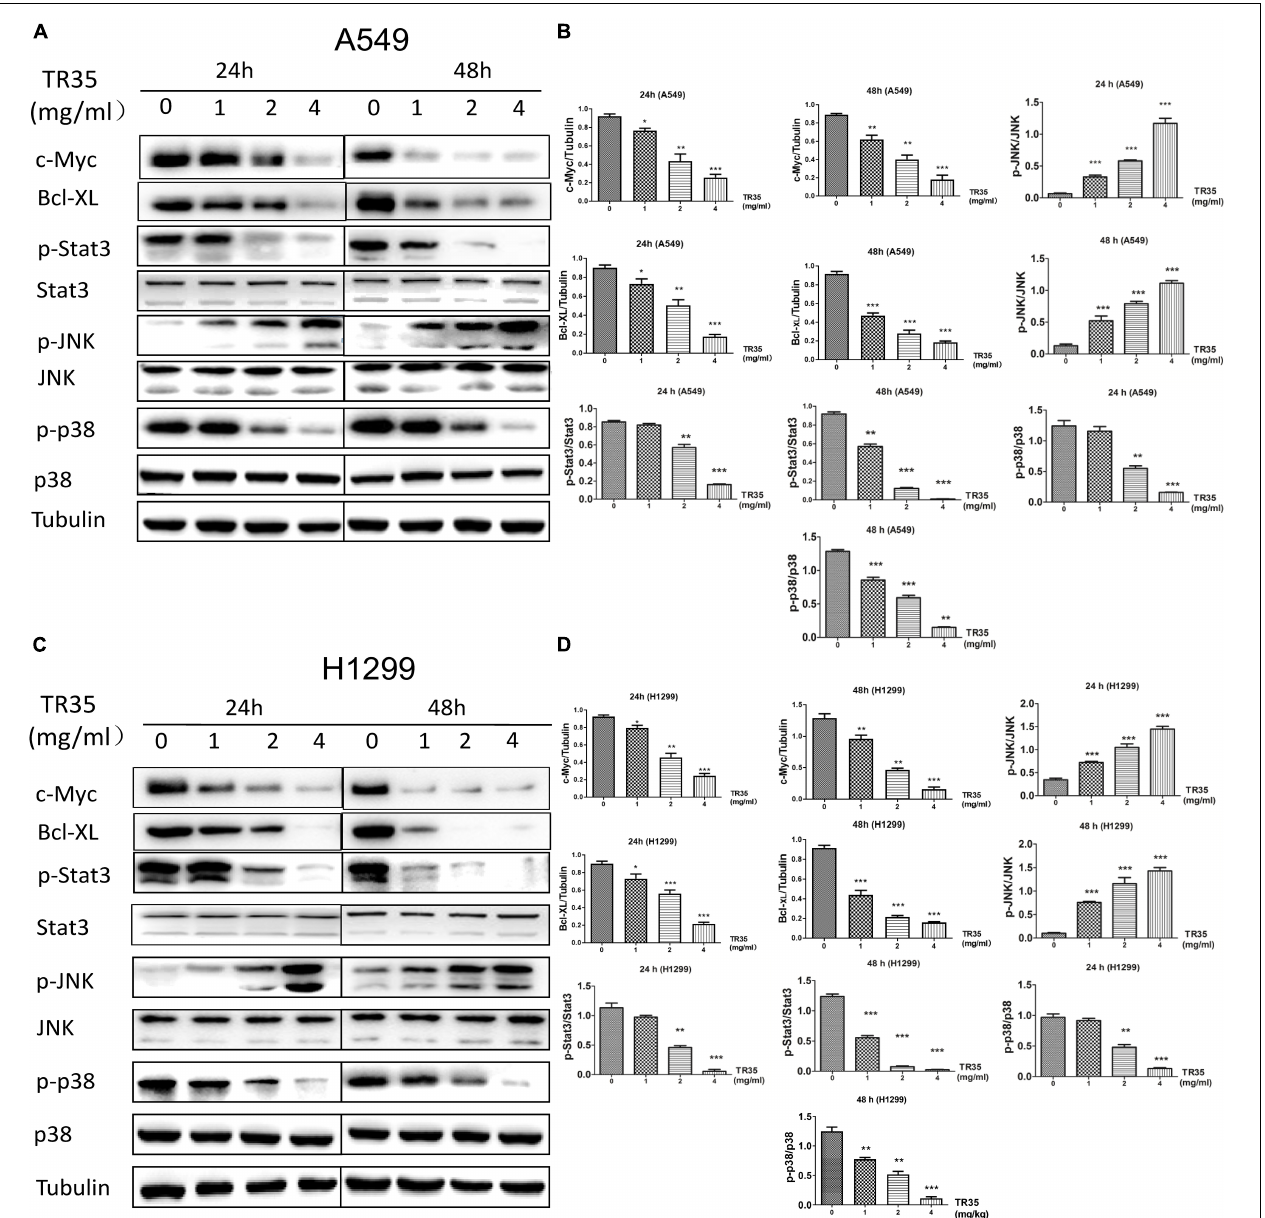
Frontiers in Cell and Developmental Biology |